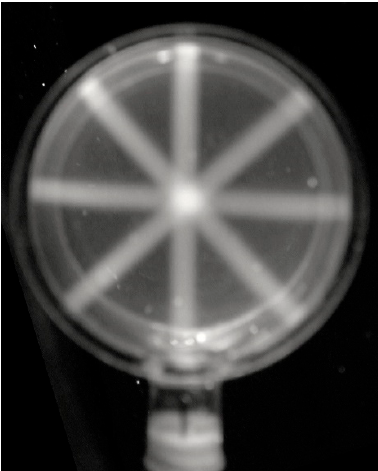
Figure 10. The fluorescence of a 6 mm thick RFG gel in a 50 mm diameter cylindrical quartz cell after irradiation with a 2.5 mm collimated, 250 kVp X-ray beam at 0, 45, 90, and 135 degrees to the vertical.